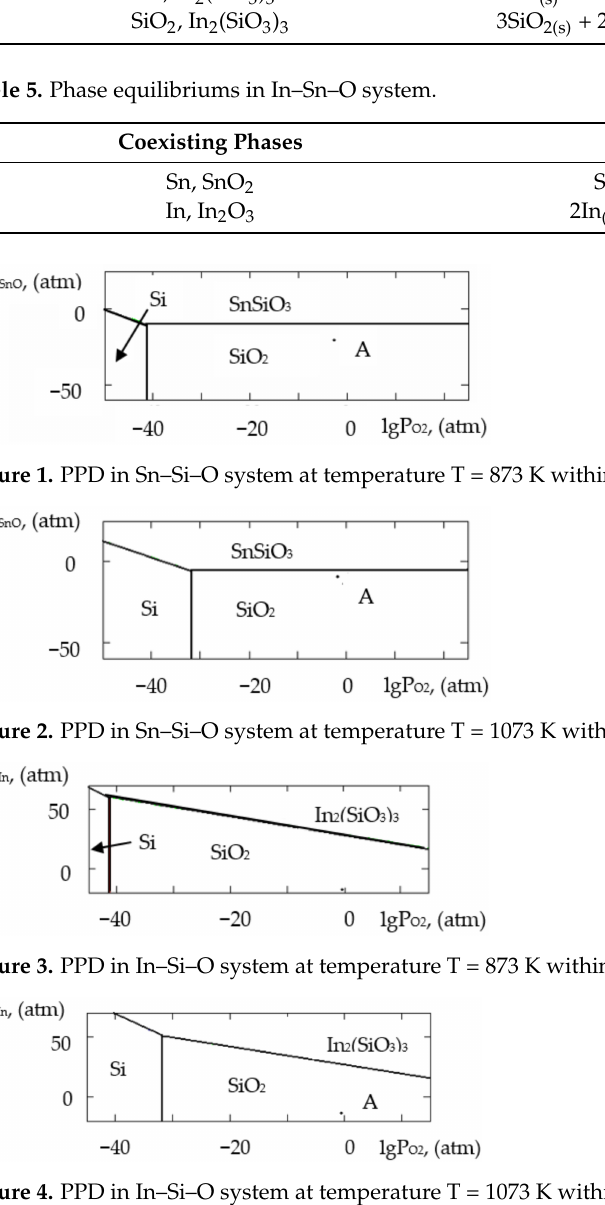
Figure 4. PPD in In–Si–O system at temperature T = 1073 K within lgP O2 –lgP In